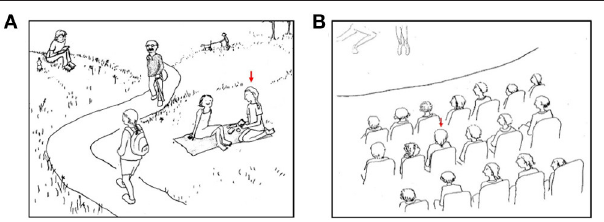
FIGURE 2 | Two examples of sketches of situations related (A) and unrelated (B) to eating. Participants were asked to imagine being the person marked with a red arrow. These sketches were accompanied by the following descriptions: (A) “You are at a picnic with a friend. You are eating a sandwich.” (B) “You are at a performance. You are watching it intently”.